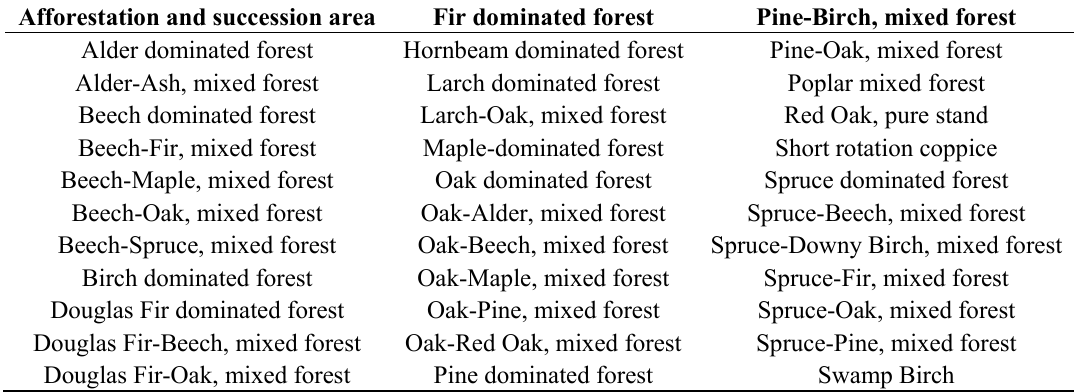
Table A2. List of the forest land use classes; these include current stand types as well as not yet established stand types of the renewed silvicultural strategy for Climate Change adapted forest management (further called “development types”) [48].